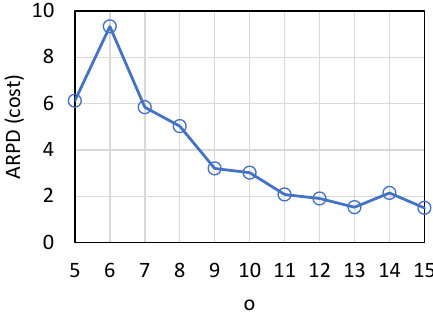
Figure 16. ARPD corresponding to Figure